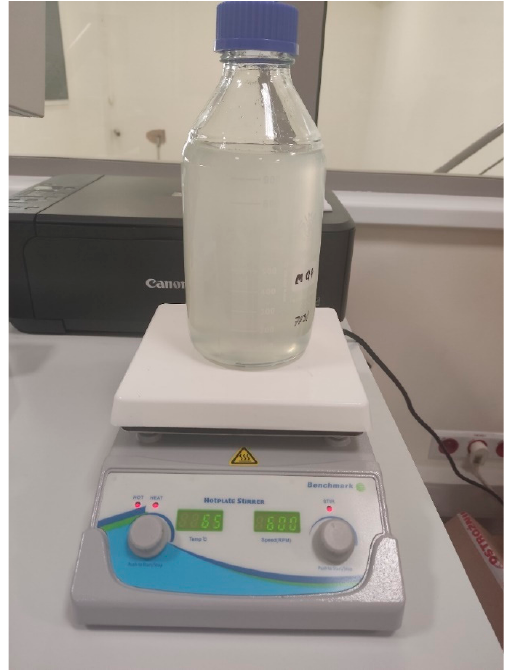
Figure 2. Used magnetic stirrer with example sample.